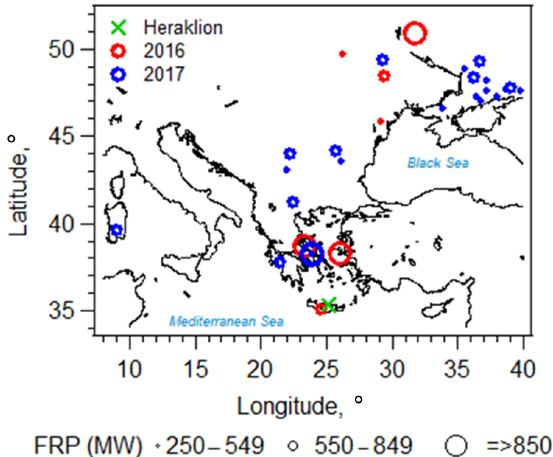
Figure 1. Locations of biomass burning events relevant to the current study, as detected by the Moderate Resolution Imaging Spectroradiometer (MODIS) and the Fire Information for Re- source Management System (FIRES; https://firms.modaps.eosdis. nasa.gov/map/, last access: 26 June 2018) during the fire seasons in 2016 (red circles) and 2017 (blue circles). The corresponding MODIS-measured fire radiative power (FRP; in megawatts) is rep- resented by the size of the circle markers and is provided as a rough proxy of biomass burning emission rate (Wooster, 2002). Wildfires with FRP less than 100MW are not shown here. The location of the sampling site (Heraklion, Crete, Greece) is indicated by the green